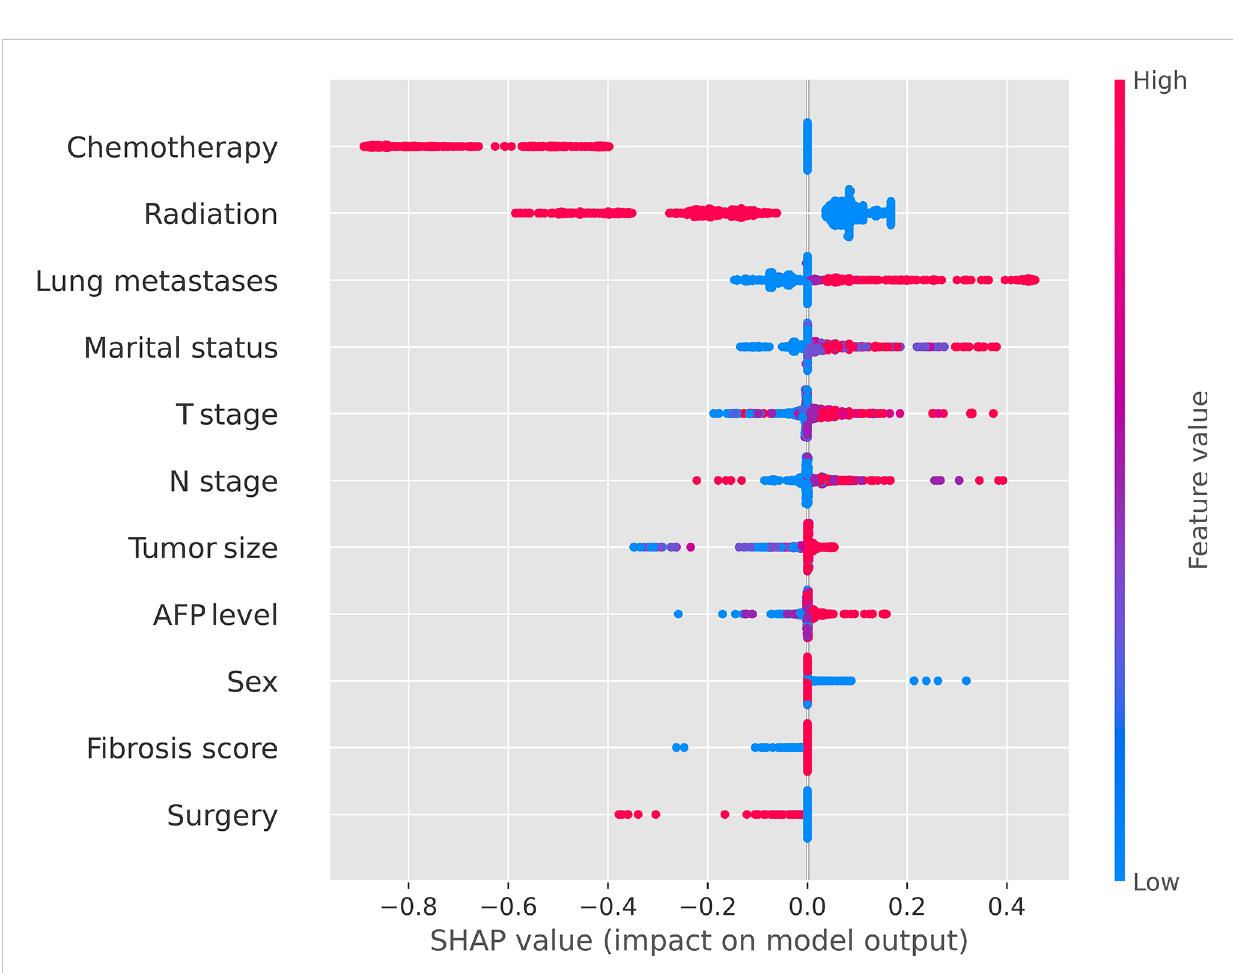
FIGURE 6 Feature importance in terms of the ensemble machine learning